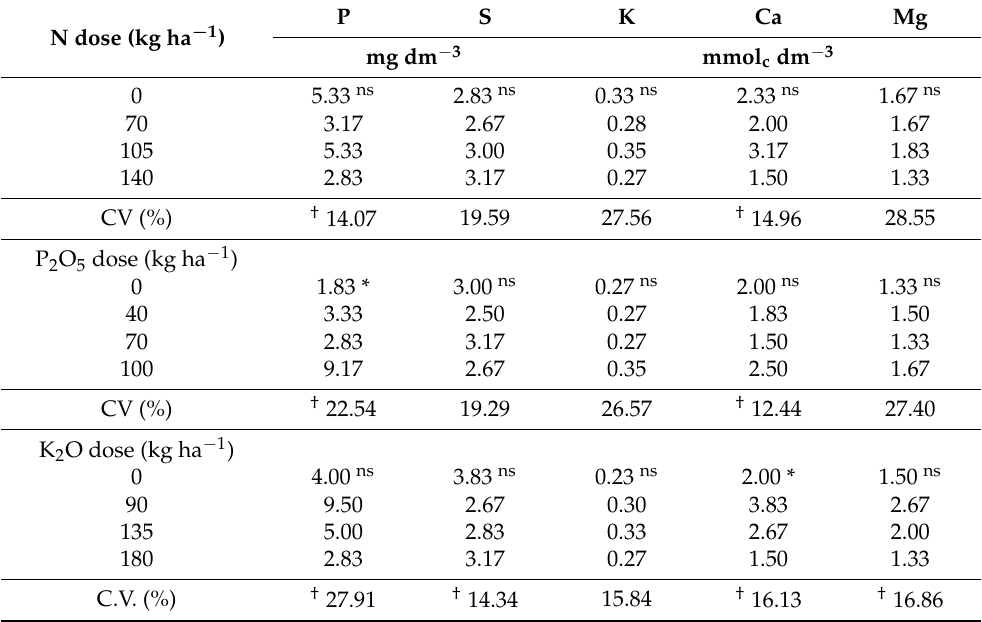
Table 1. Mean soil macronutrient contents at a depth of 0–20 cm after seventy-six months of eucalyp- tus plantation as a function of N, P 2 O 5 and K 2 O fertilization